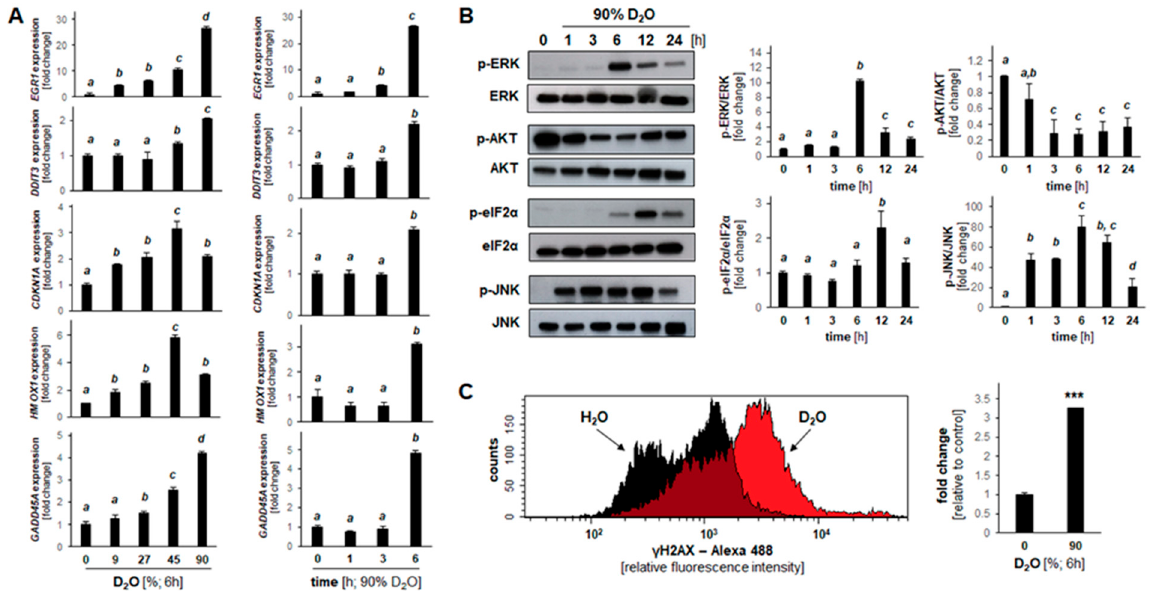
Figure 4. D 2 O-induced stress response gene expression and rapid onset of modulated phospho-protein signaling in A375 melanoma cells. ( A ) RT-qPCR assessment of gene expression; left row, dose response ( ≤ 90 % D 2 O); right row, time course ( ≤ 6 h). ( B ) Stress response protein phosphorylation in response to acute D 2 O exposure as profiled by immunoblot analysis: time course (90% D 2 O; ≤ 24 h). Bar graphs summarize quantitative analysis by densitometry (mean ± SD). ( C ) For γ H2AX detection, flow cytometry was performed; bar graphs summarize quantitative analysis (mean ± SD; n = 3; p *** <